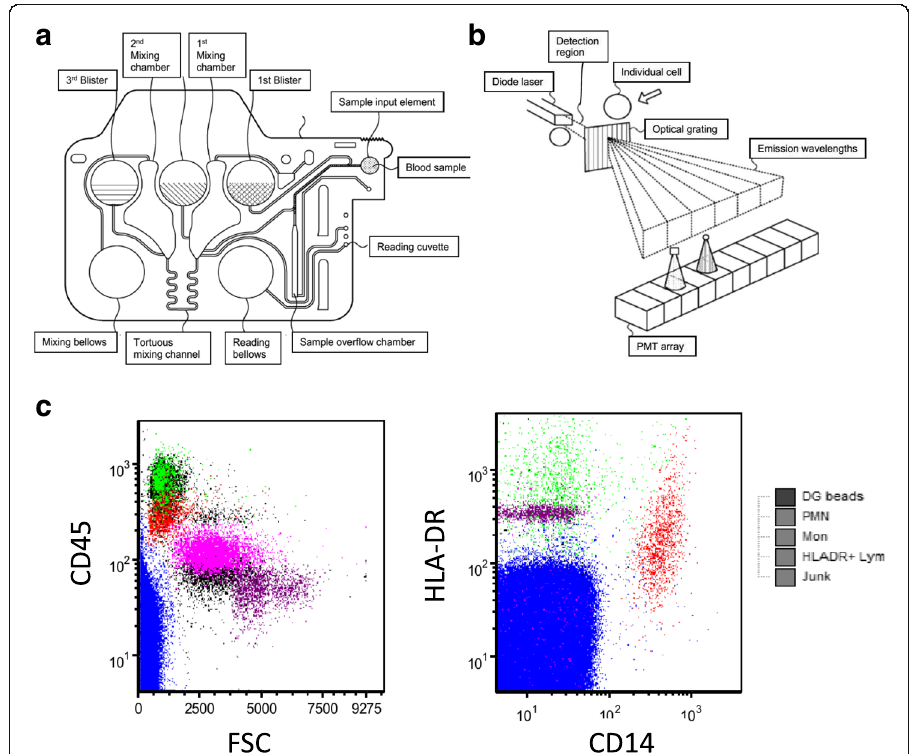
Fig. 1 Key elements of the Accellix cartridge based HLA-DR flow cytometry assay. a Cartridge. The sample is added to the cartridge, which is then placed in the reader instrument. Reagents are added to the sample by crushing the 1st blister on the cartridge that releases the reagents and simultaneously moves the sample to a first mixing chamber. Additional mixing is performed by moving the composition of the sample and reagents from one mixing chamber to the other through a tortuous path by compressing and releasing a polymer bellows in order to alternately apply pressure and vacuum to the sample. After the incubation period, emission level reference beads are added by crushing the 3rd blister to release the beads into the 2nd mixing chamber. The resulting composition is again moved back and forth between the two mixing chambers in order to obtain a uniform particle suspension. At the end of this mixing process, the composition is in the first mixing chamber. The reading bellows, which had been previously compressed, is now released in order to apply vacuum to draw the specimen from the first mixing chamber through the reading cuvette. b Optical detection. Fluorescence emission detection is performed by dispersing the emission using an optical grating and collecting the dispersed emission using a PMT array. c Dot plot histograms. Results from the automatic classification algorithm are shown on the 2 plots. First, junk is excluded based on the absence of any fluorescent signal. Reference beads are identified because they do not express pan WBC CD45 marker. PMNs used as a negative control are identified based on the levels of CD45, CD14, and forward scatter. Finally, lymphocytes used as a positive control are separated from monocytes based on CD14 expression. Importantly, it is to note that these histograms are not accessible to Accellix users and are only provided here as an illustration of cell identification